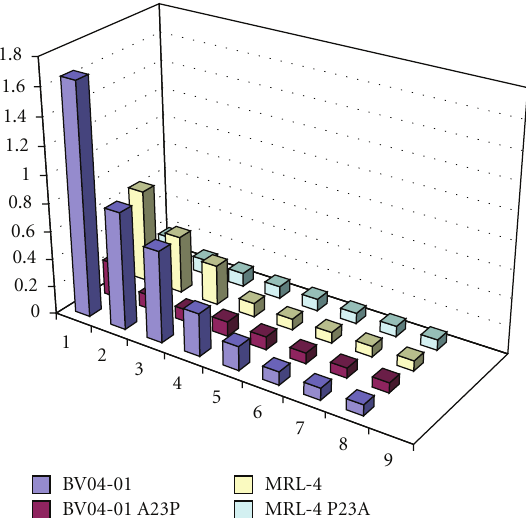
Figure 2: DNA binding by BV04-01 and MRL-4 single-chain antibodies and their mutants assayed by ELISA. Vertical axis represents absorbance measured at 405 nm. Horizontal axis displays amounts of recombinant antibodies per ELISA well: 1: 5 μ g, 2: 1 μ g, 3: 0.5 μ g, 4: 0.1 μ g, 5: 0.05 μ g, 6: 0.01 μ g, 7: 0.005 μ g, 8 bu ff er without antibody. Experimental error for determined absorbance values was calculated within a series of 5-independent ELISA experiments and did not exceed 5% of medium absorbance